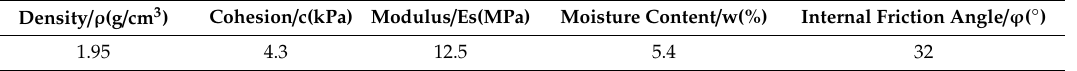
Table 1. Experimental parameters of geotechnical materials.